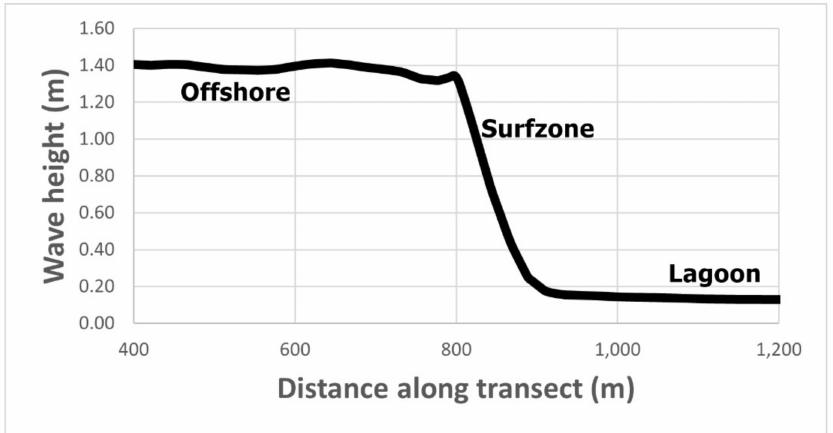
Figure 8. Wave height predicted by Model 2dBeach along the transect which goes from deep water offshore of the fringing reefs, across the fringing reef in the surf zone and across the lagoon to the study site. The transect position is shown in Figure